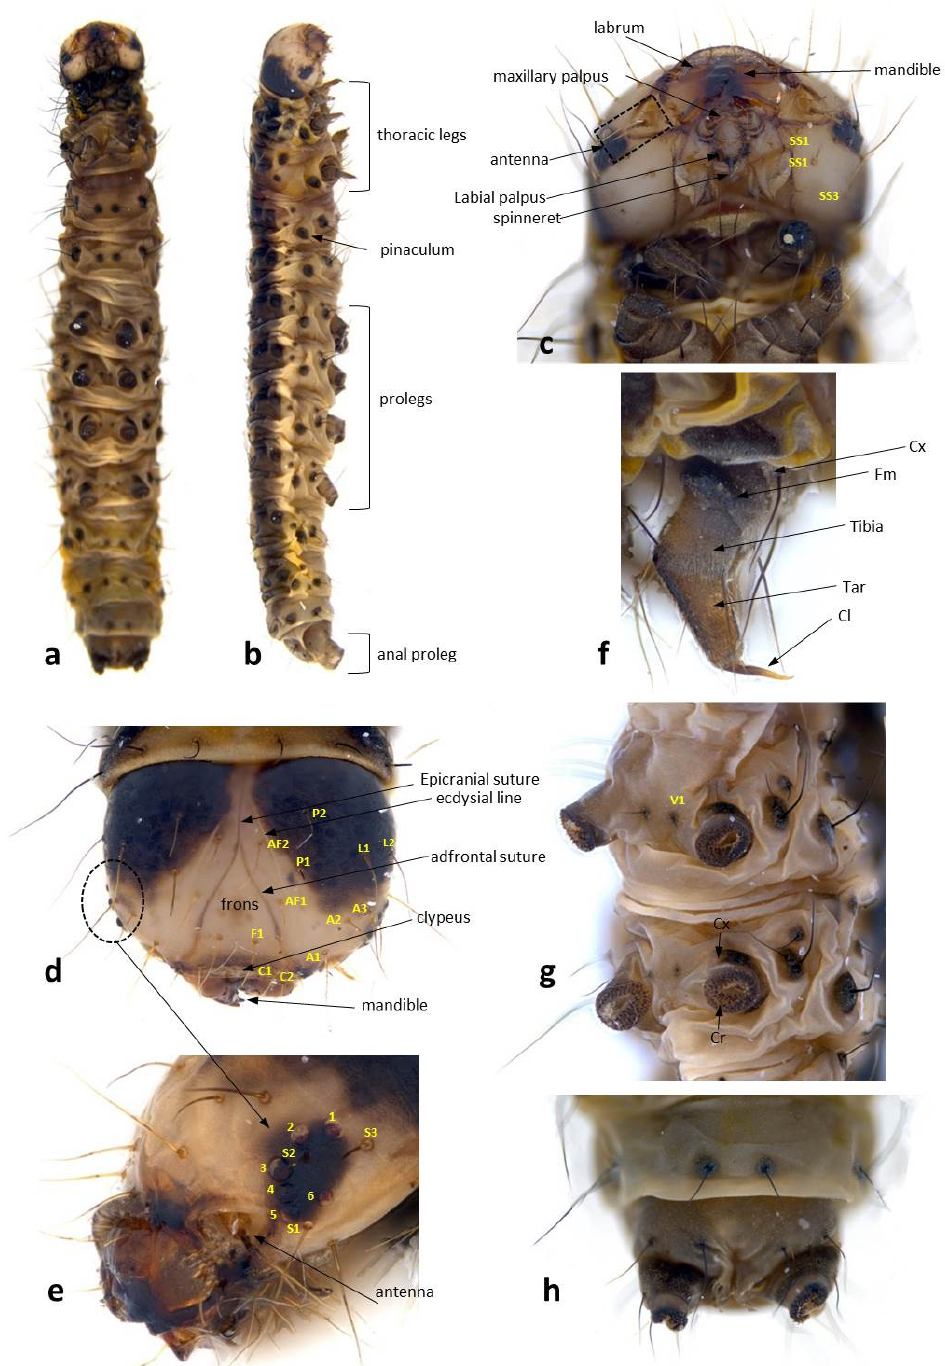
Figure 2. Larva of Yponomeuta meguronis : ( a ) ventral view; ( b ) lateral view; ( c ) frontal and ventral view of head; ( d ) frontal and dorsal view of head; ( e ) lateral view of head; ( f ) thoracic leg; ( g ) crochets of prolegs; ( h ) anal proleg. Abbreviation: A, anterior setae; AF, adfrontal setae; C, clypeal setae; F, frontal setae; L, lateral setae; P, posteriodorsal setae; S, stemmatal setae; V, ventral setae; Cx, prothoracic coxa; Cr, crochets. Six stemae: 1, 2, 3, 4, 5 in a semicircular shape, stema 6 anteroventral to stema 4. Clypeus sclerotized with dark brown posterior margin. Antennae is brown, with three antennomers: basal one wider with one sesilla; the second narrower and extended with five segmented, bearing two sesilla setae: one longer and the other shorter.